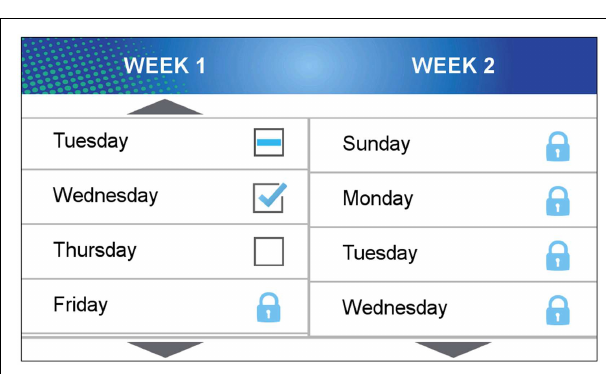
FIGURE 5 | Screenshot of the activity selection list from the sensor-assisted end-of-day recall component .